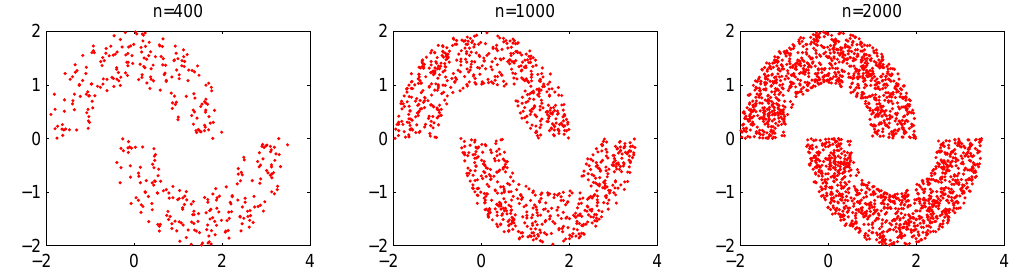
Figure 23. Synthetic dataset with different data numbers from